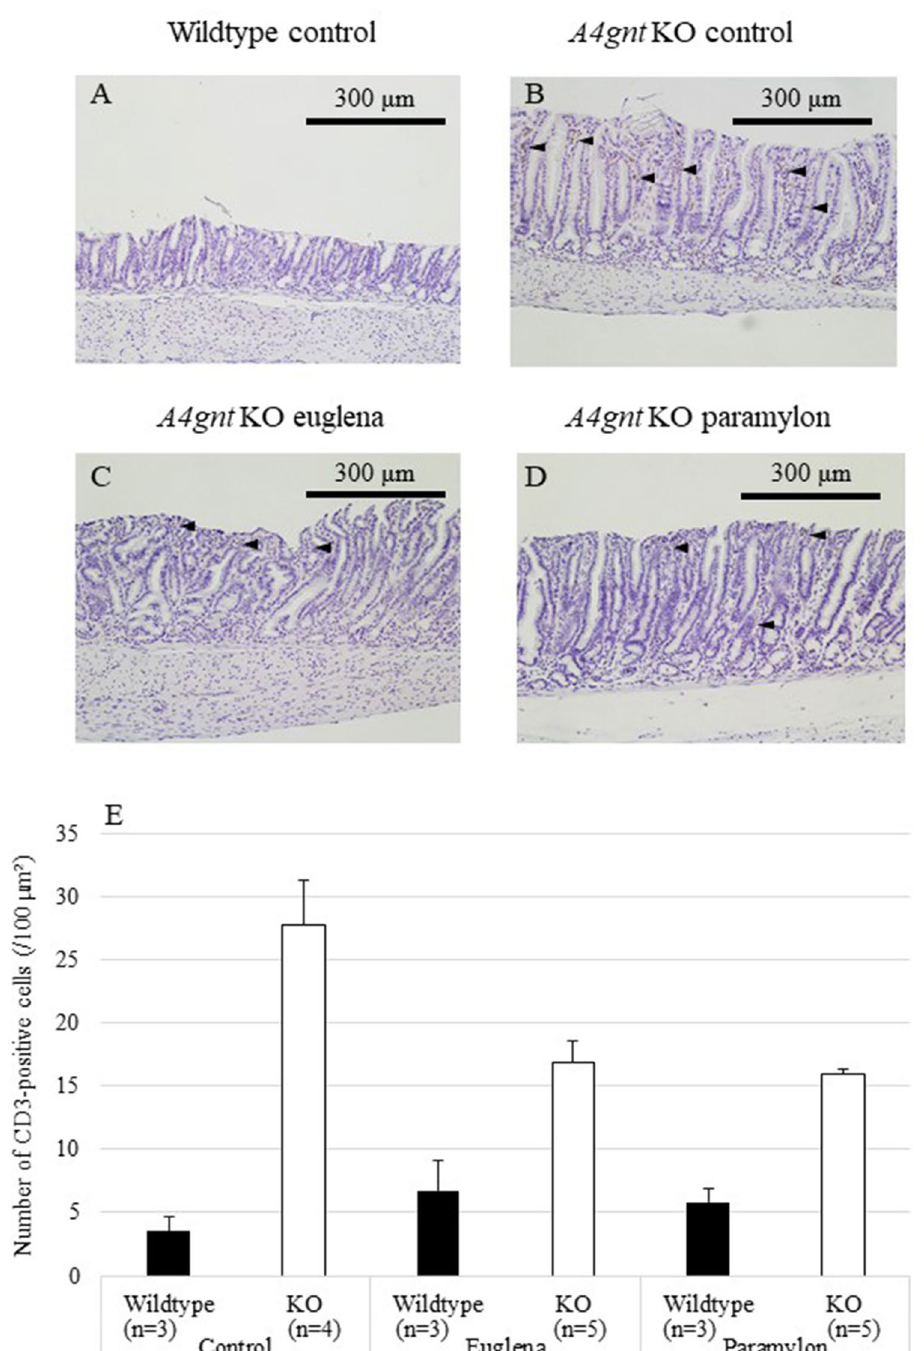
Figure 3. Numbers of CD3-positive lymphocytes in gastric mucosa of A4gnt KO and wildtype mice. ( A ) Wildtype mouse administered saline. ( B ) A4gnt KO mouse administered saline. ( C ) A4gnt KO mouse administered 50 mg/day of Euglena . ( D ) A4gnt KO mouse administered 50 mg/day of paramylon. CD3-positive cells were stained brown by diaminobenzidine tetrahydrochloride. ( E ) Mean ± SD of numbers of CD3-positive cells in pyloric mucosa. Arrowheads indicate CD3-positive cells. The mean number of CD3-positive cells in gastric mucosa of A4gnt KO mice was significantly more than that of wildtype mice. Administration of Euglena and paramylon significantly reduced the number of CD3-positive cells of A4gnt KO mice compared with those in control group administered with